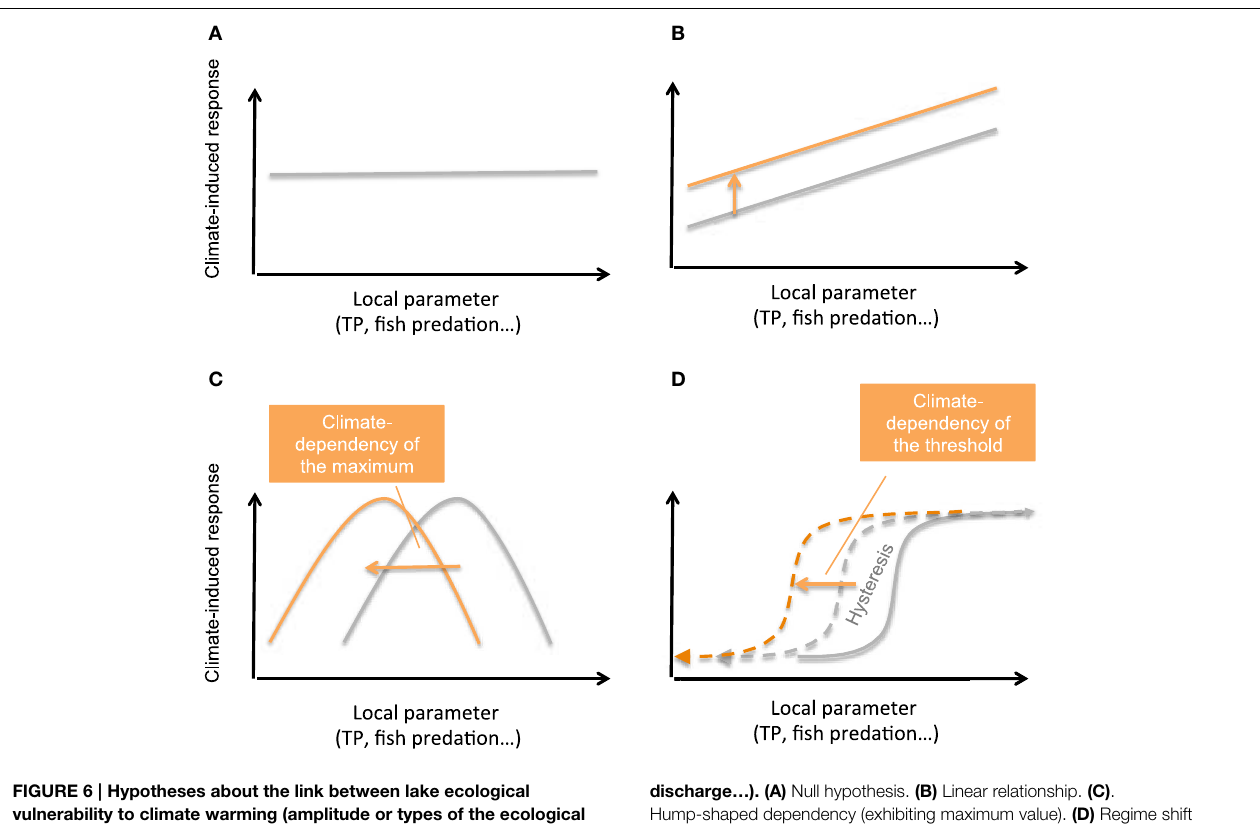
discharge…). (A) Null hypothesis. (B) Linear relationship. (C) . Hump-shaped dependency (exhibiting maximum value). (D) Regime shift dependency (exhibiting threshold value). Gray and orange lines depict relationships for current and projected climate